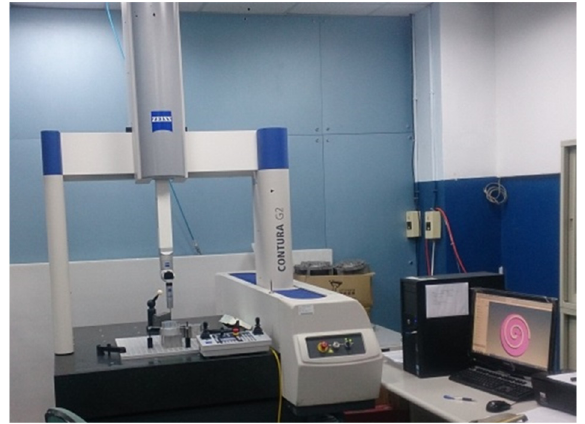
Figure 16. Measurement of the profile errors for scrolls.